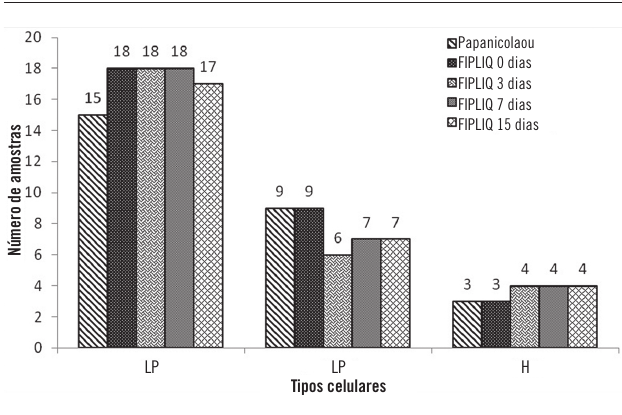
figura 2 − Leucócitos polimorfonucleares, histiócitos e sangue em amostras cervicais de Papanicolaou e FIPLIQ após 0, 3, 7 e 15 dias de preservação celular Não houve diferença estatisticamente significante (teste z , p = 0,05). FIPLIQ: fosfato de formaldeído-isopropanol; LP: leucócitos polimorfonucleares; HIST: histiócitos; H: